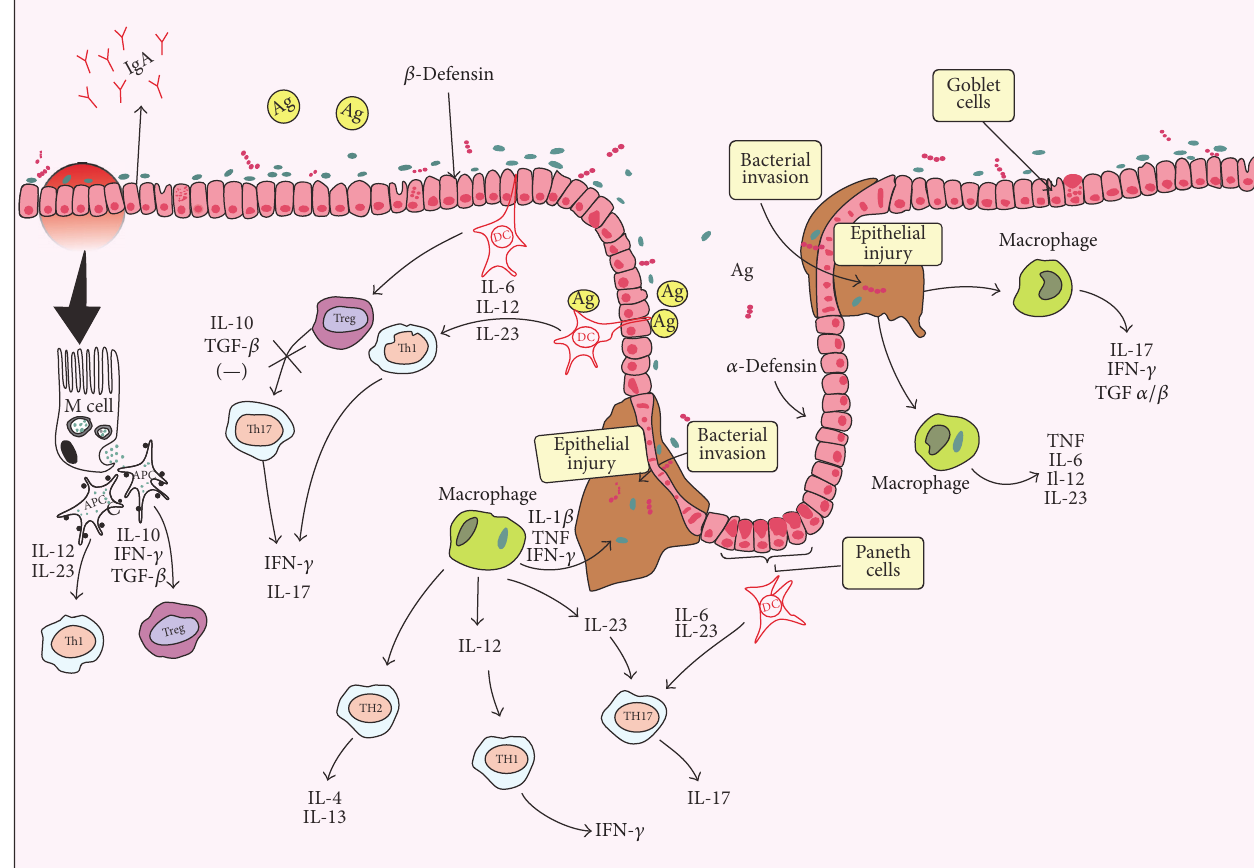
Figure 1: Intestinal epithelial barrier and the immune system in inflammatory bowel disease. Ag: antigen; APC: antigen presenting cells; IL: interleukin; IFN- 𝛾 : interferon gamma; IgA: immunoglobulin A; M cell: microfold cell; TGF- 𝛽 : transforming growth factor beta; TGF- 𝛼 : transforming growth factor-alpha; Th: T helper cell; Treg: regulatory T cells; TNF: tumor necrosis